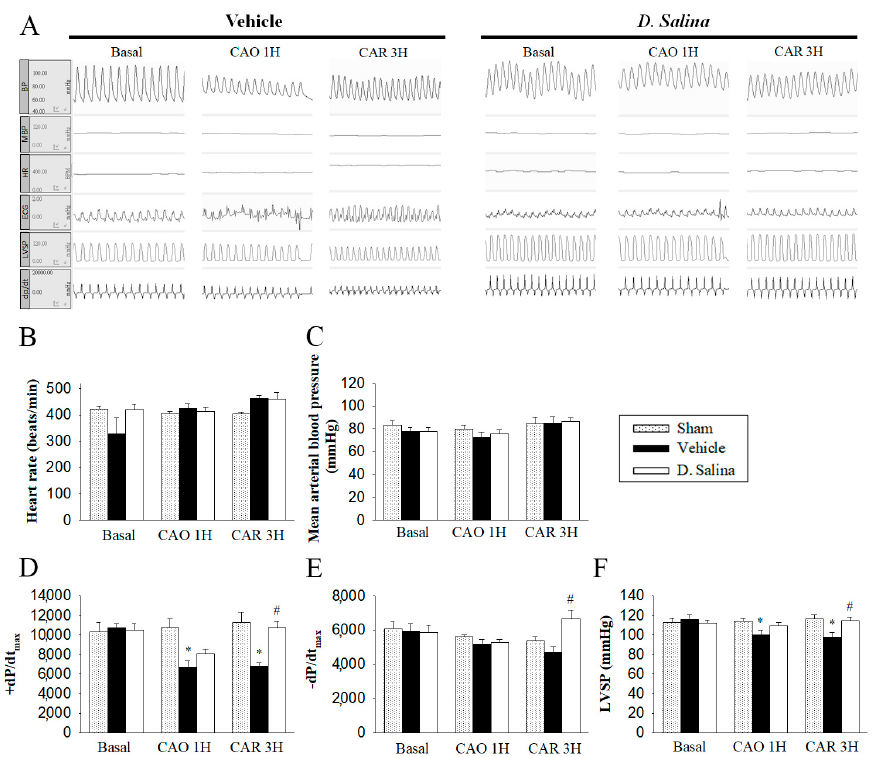
Figure 2. Effect of D. salina on hemodynamic parameters in rats subjected to myocardial I/R injury. ( A ) Representative image of hemodynamic parameters between the vehicle- and 1 mg/kg D. salina - treated rats during myocardial I/R injury. Quantitatively analyzed results of ( B ) heart rate, ( C ) mean arterial blood pressure, ( D ) maximum rates of pressure change in the LV (+dP/dt), ( E ) minimum rates of pressure change in the LV ( − dP/dt) and ( F ) left ventricular systolic pressure (LVSP) were recorded by physiological parameters (CAO1H, 1 h after LAD coronary artery occlusion; CAR3H, 3 h after LAD coronary artery reperfusion). Values are mean ± S.E.M.; ( n = 8 per group); # p < 0.05 compared with the sham group; * p < 0.05 compared with the vehicle-treated group.